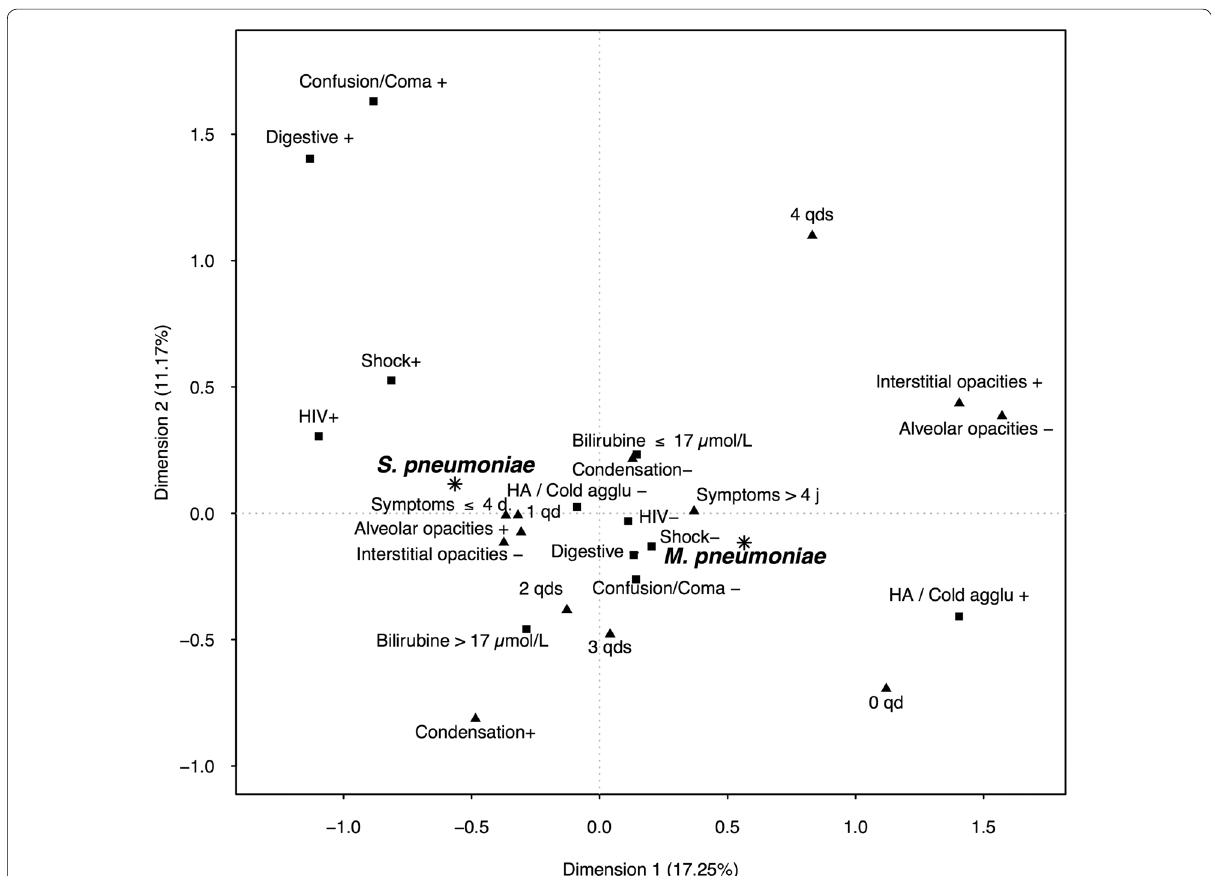
Fig. 2 Multiple correspondence analysis: the factors are mapped along two dimensions. Triangles indicate pulmonary signs and squares extra-pulmonary signs. HA hemolytic anemia, Cold agglu presence of cold agglutinins, QD +